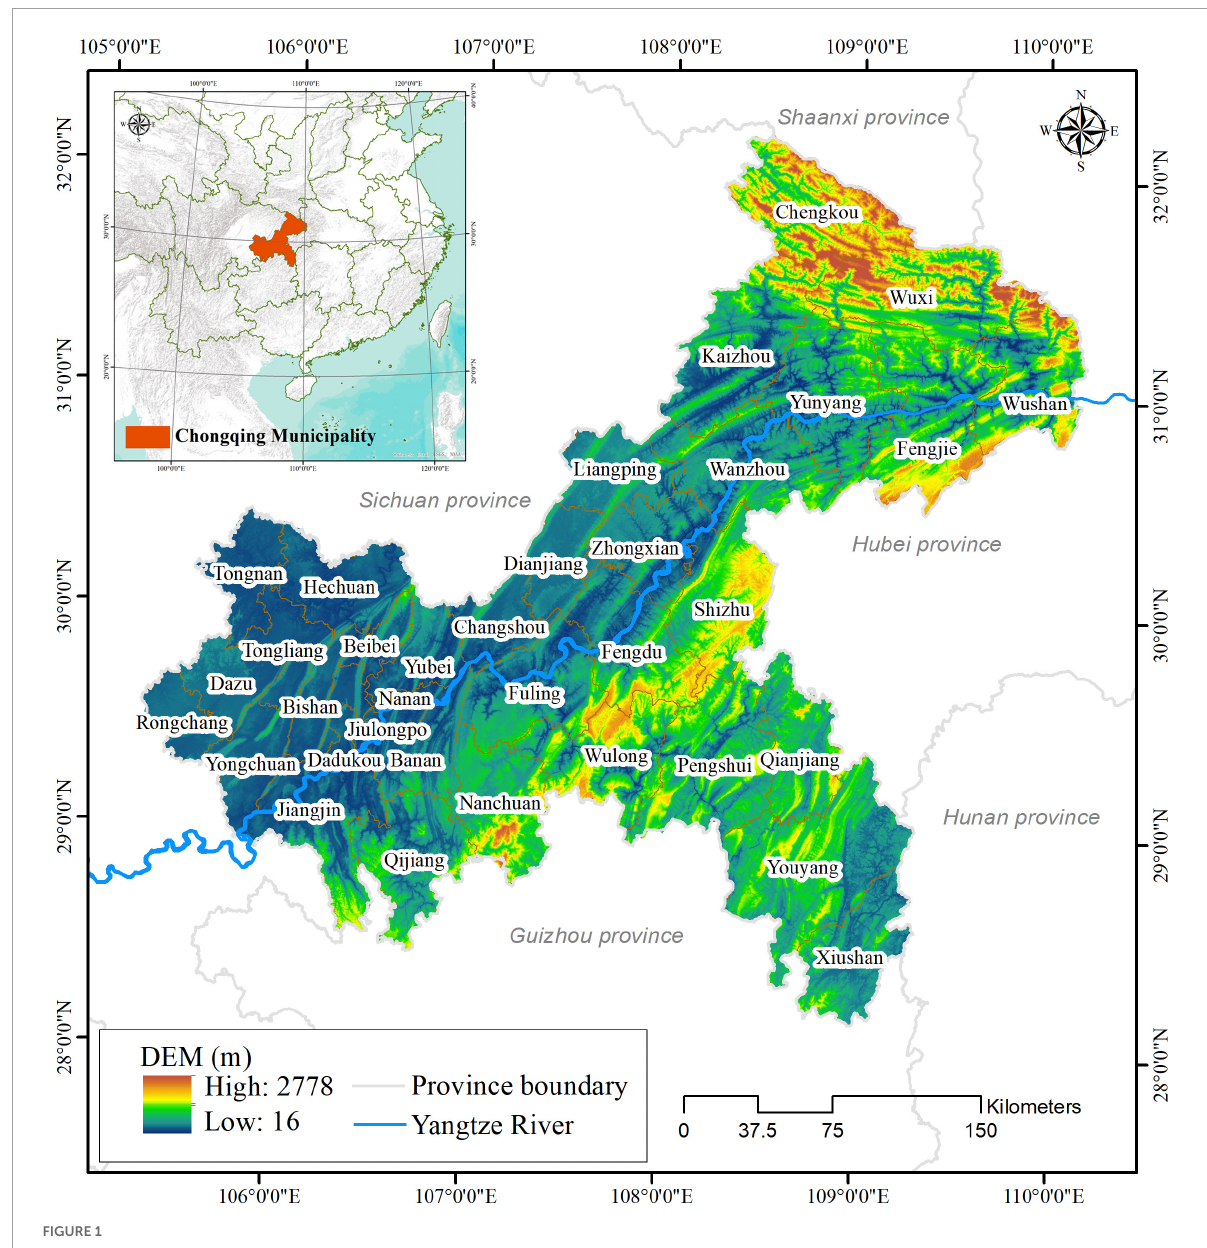
FIGURE1 The geographical location of Chongqing Municipality, China.